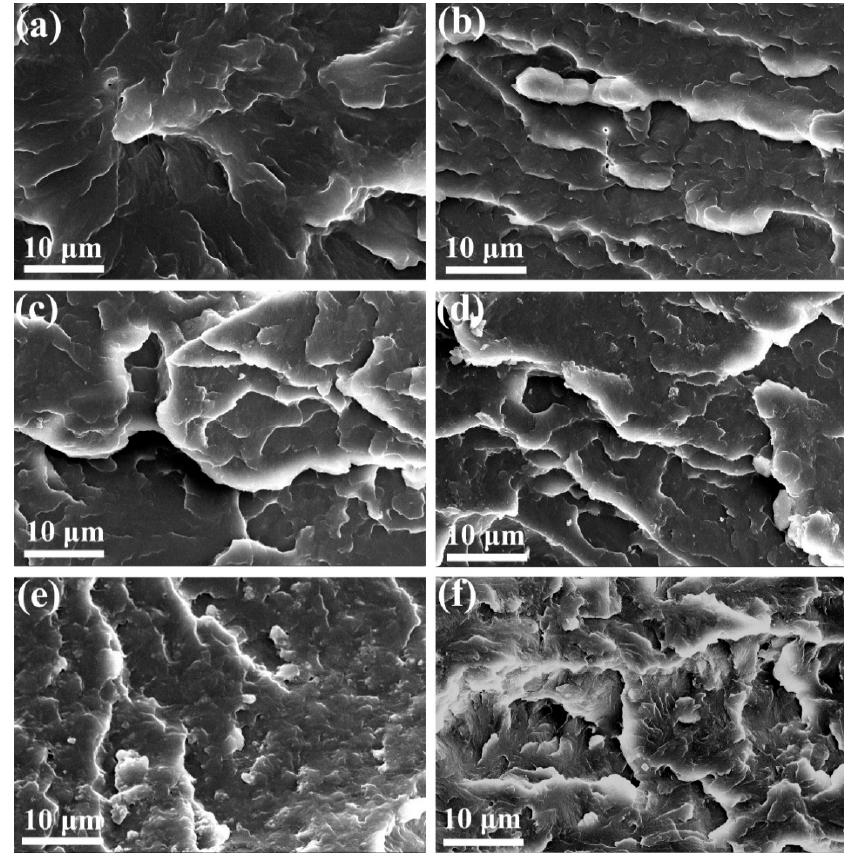
Figure 5. SEM micrographs of impact fracture surfaces of ( a ) pure POM and its blends with ( b ) 10 wt %, ( c ) 20 wt %, ( d ) 30 wt %, ( e ) 40 wt %, and ( f ) 50 wt % of PLA.